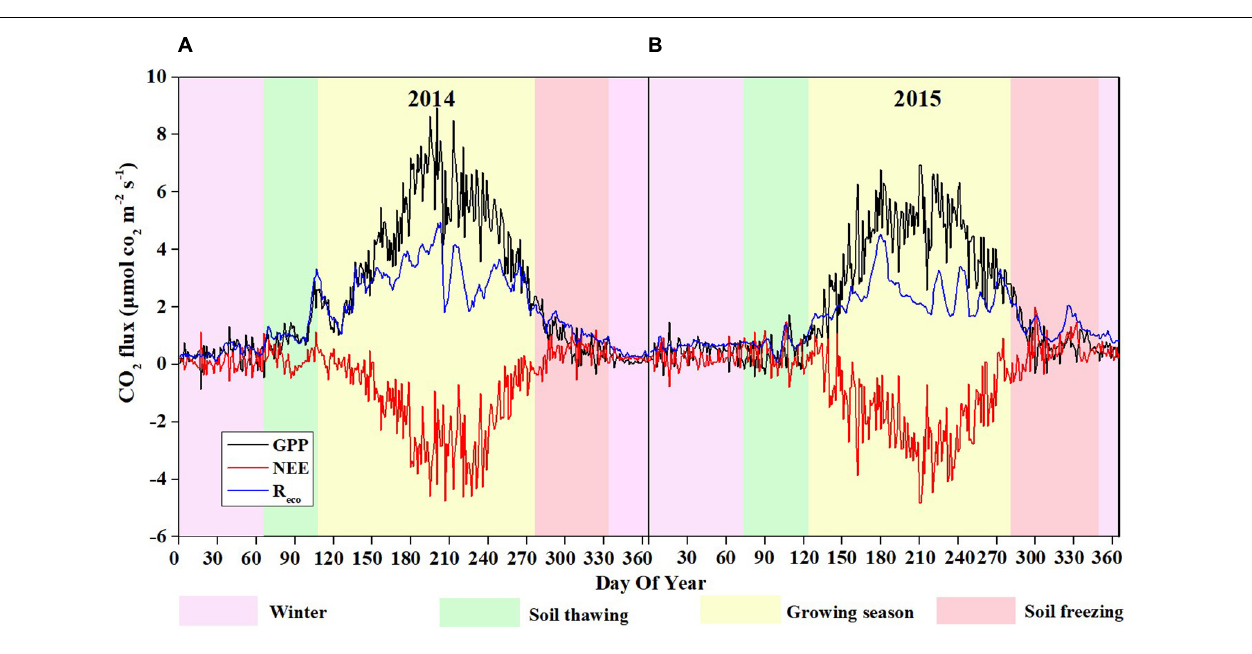
Continuous wavelet transformation has revealed the local characteristics of NEE and environmental variables in the time- frequency domain ( Figure 7 ). The diurnal variation of NEE was inconsistent throughout the growing season. The NEE oscillated